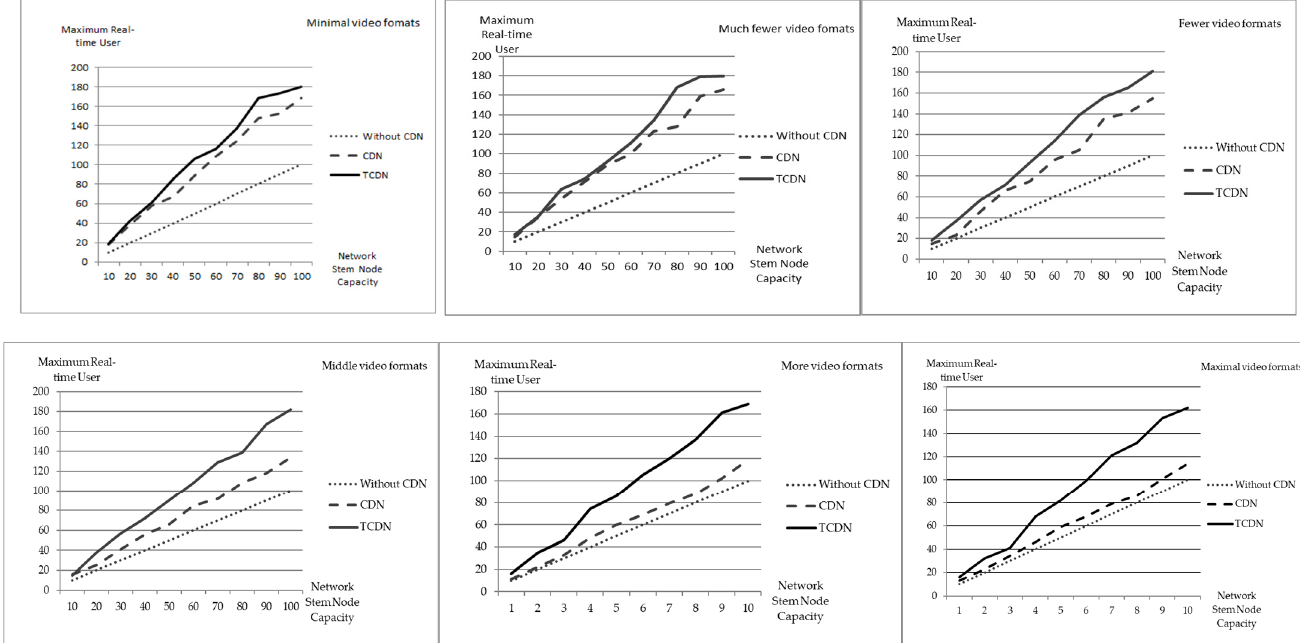
Figure 5. Diagram of the maximum real-time user supported in different video format